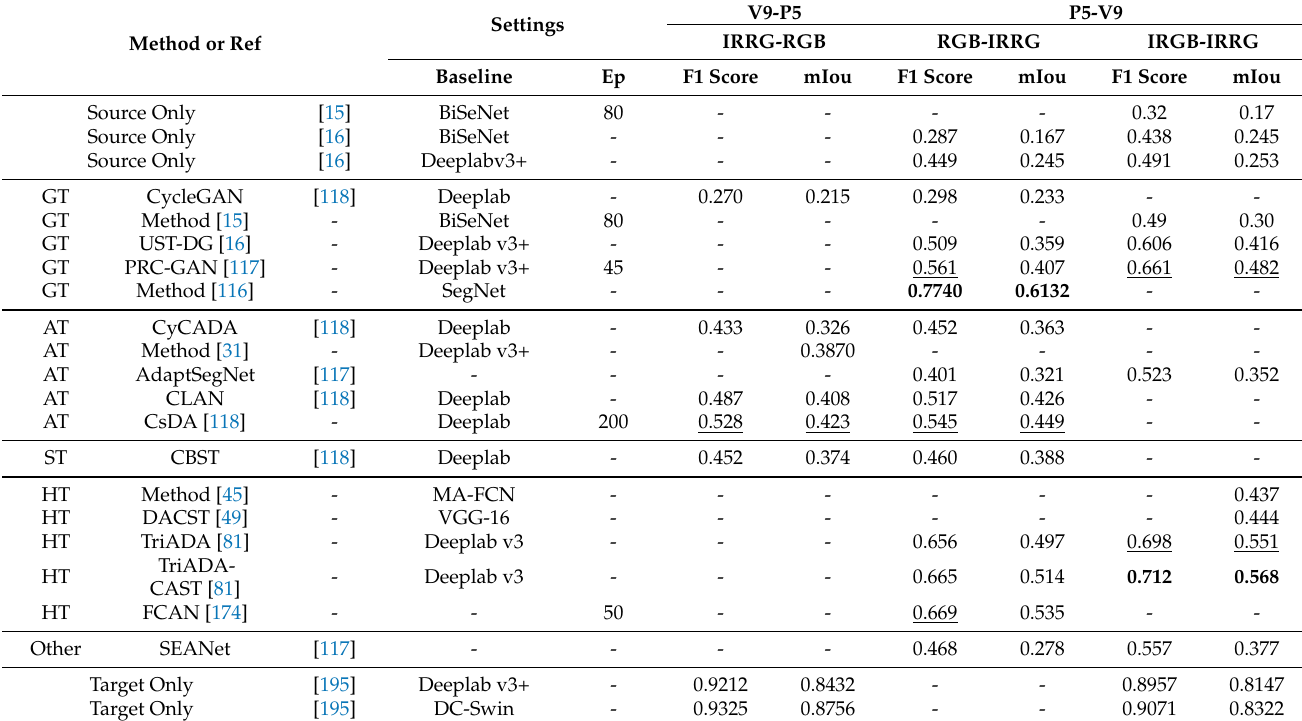
Table 2. The experimental results based on the ISPRS Potsdam and Vaihingen datasets for six types of segmentation task using different constitution and resolution bands. Bold text represents the best performance in our statistical experimental results, while underlined text represents the second best performance in a certain class of